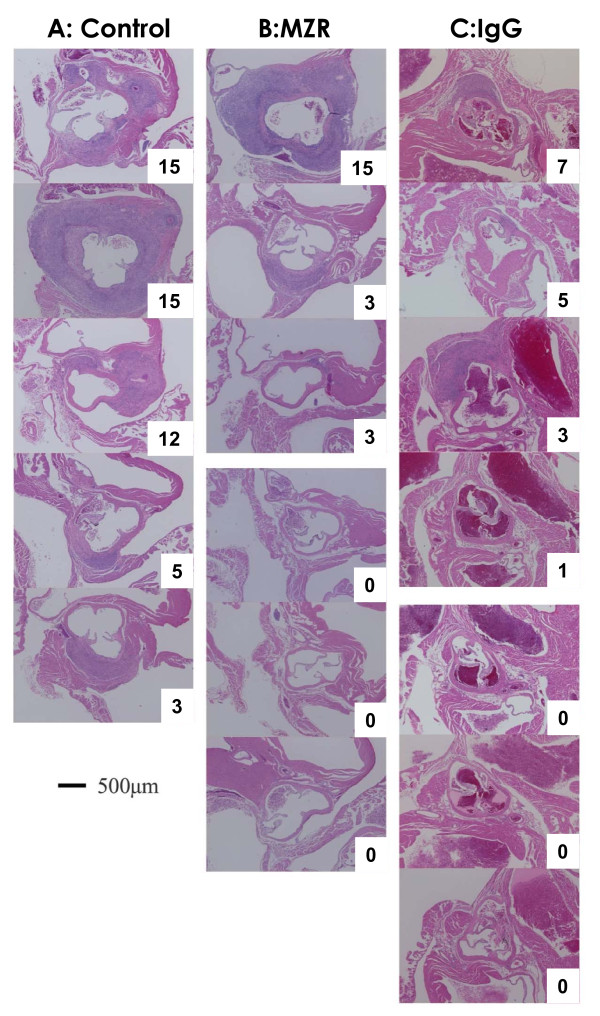
Histological observations of coronary arteritis induced by treatment with MZR and IgG. A, Control (PBS); B, MZR group; C, IgG group. Each micrograph represents an individual mouse. H&E stain, Bar: 500 μm. Numbers (white) are coronary arteritis score.